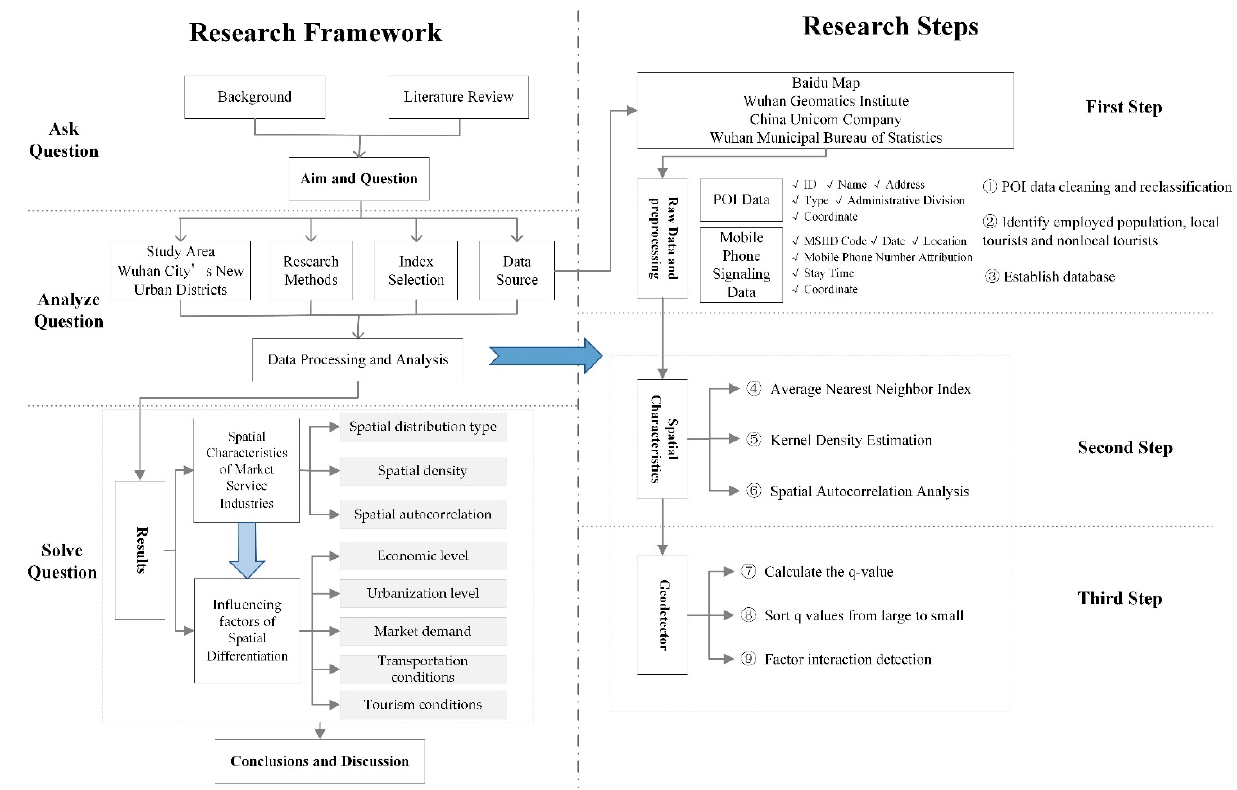
Figure 1. Research framework and steps .